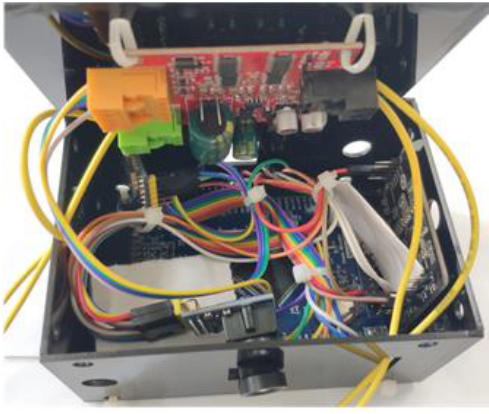
Figure 10. The control box of WRR-II.